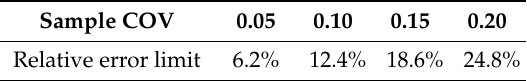
Table 6. Relative error limit in using five coupons for tensile